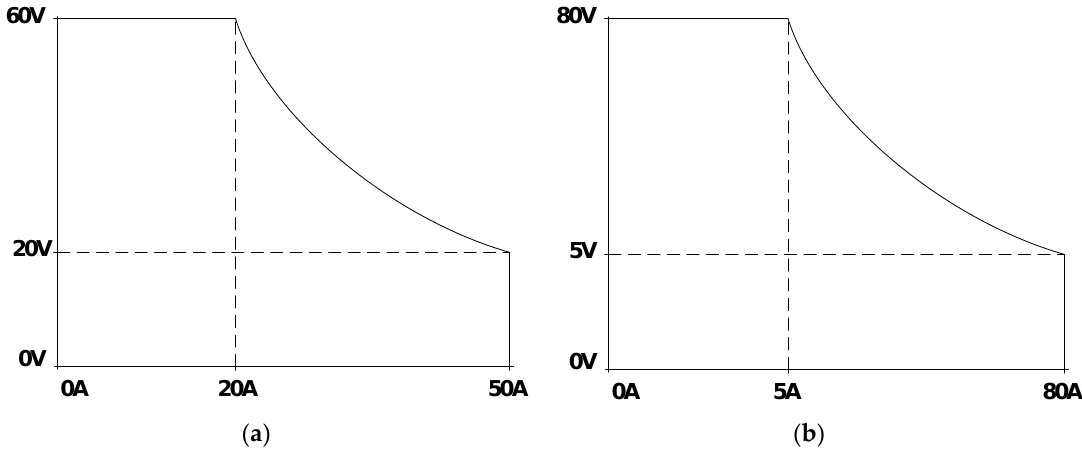
Figure 2. V-I power flex plot for: ( a ) QPX1200SP and ( b ) LD400P.